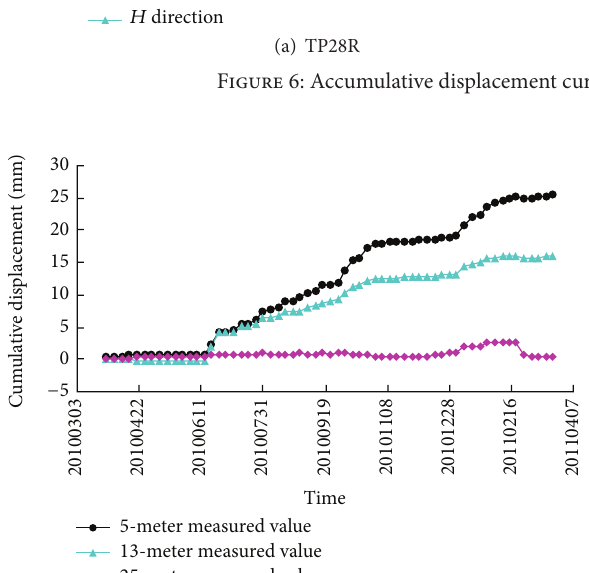
Figure 7: Accumulative displacement curves of M 4 10